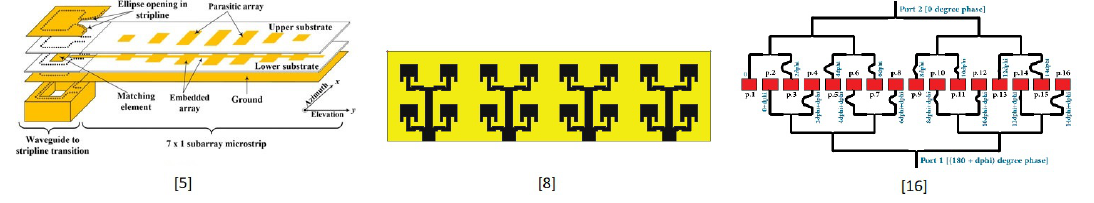
Figure 16. Architecture of some work reported in literature [5], [8], and [16]